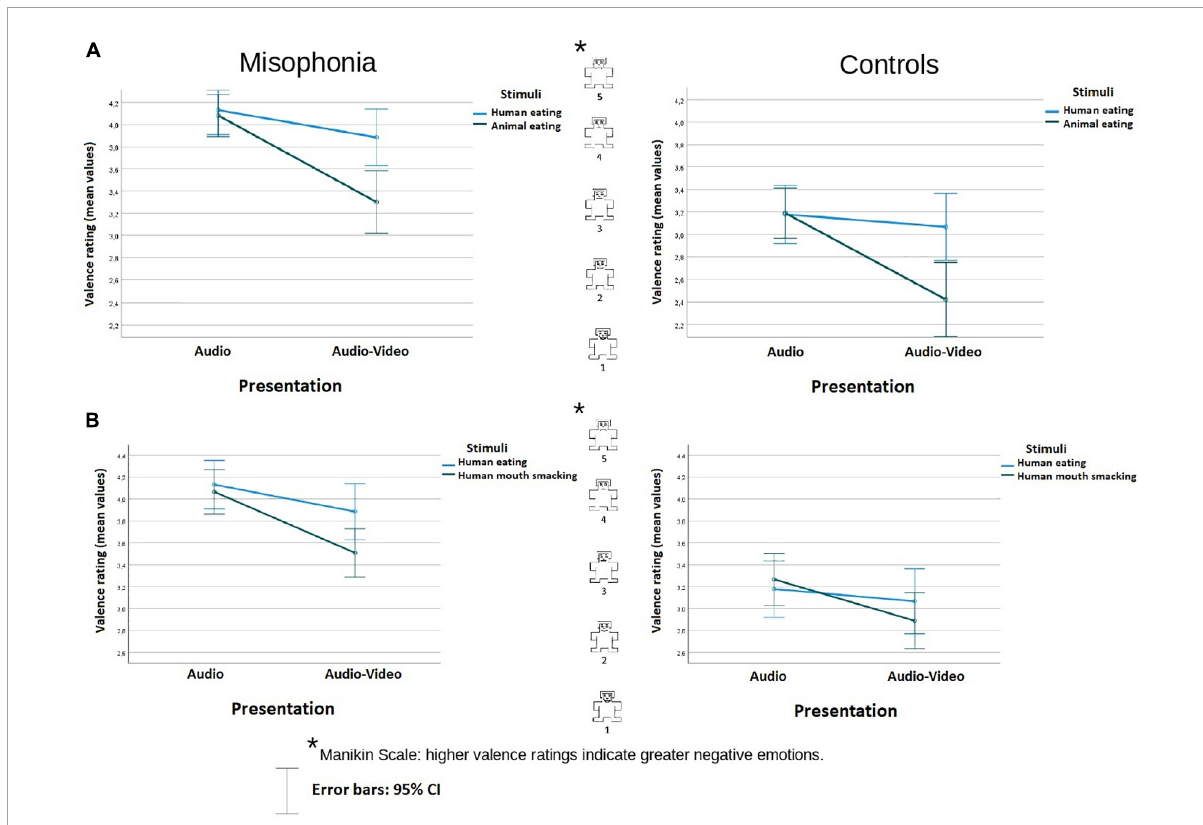
FIGURE1 Valence rating (mean values) of the stimuli in audio and audio-video conditions in misophonia and the control group, separately for the analysis (A) and the analysis (B) . Higher valence ratings indicate greater negative emotions. The distances between the scale values were identical (it is a linear